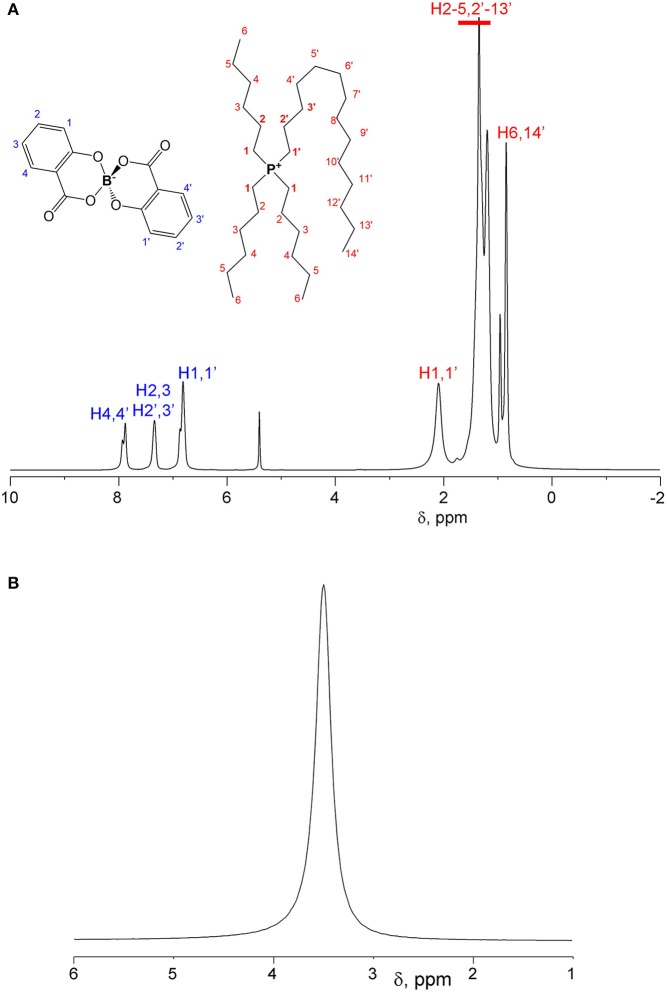
1H NMR (A) and 11B NMR (B) spectra of [P6,6,6,14][BScB] at T = 296 K.